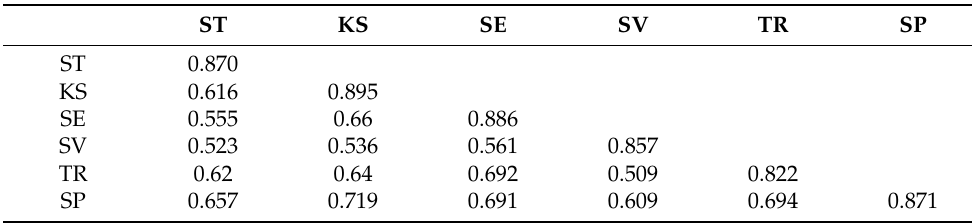
Table 7. Discriminant